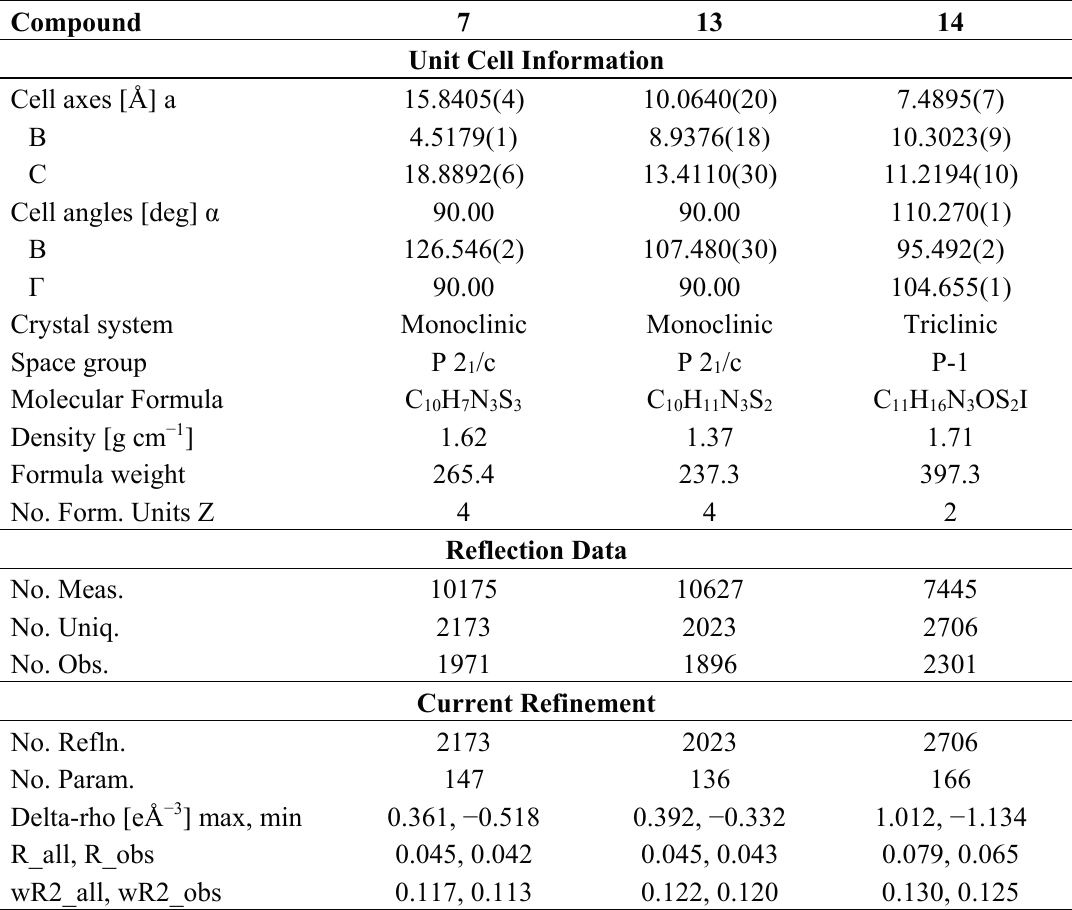
Table 4. X-ray crystal data of compounds 7 , 13 and 14